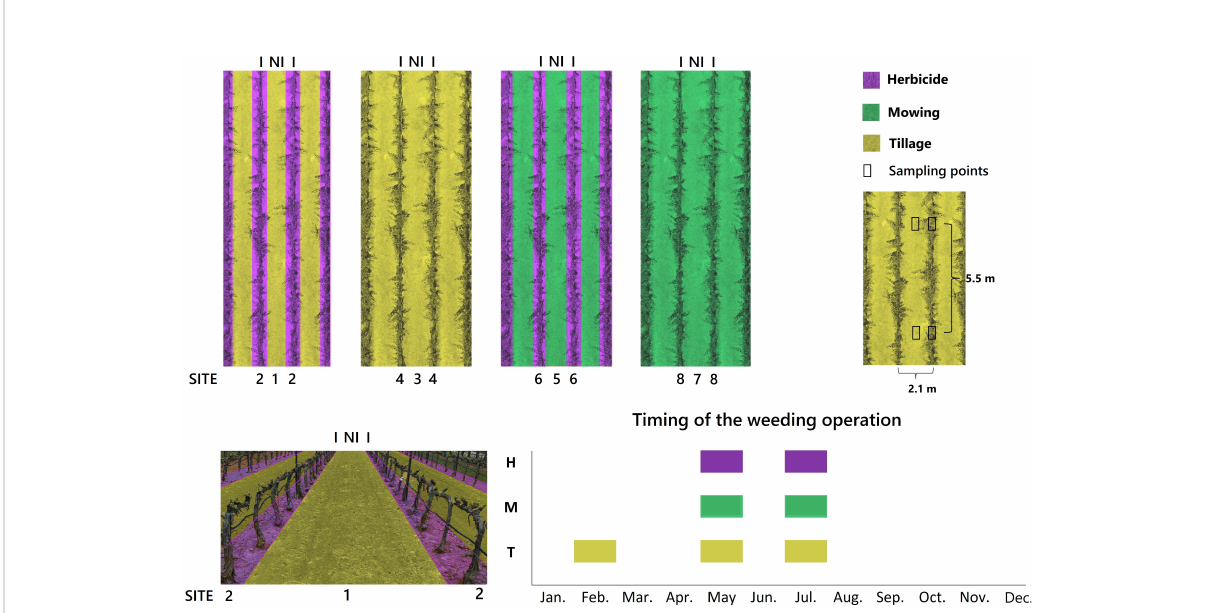
FIGURE 1 Diagram of the experimental design and location of the sampling points (upper part), 3D image depicting sites 2-1-2 (lower left) and schematic chronogram of the weeding operations carried out in the study fi eld (lower right). Irrigation treatment: I: irrigated row; NI, non-irrigated inter- row. Site: 1, tilled inter-rows adjacent to herbicide-treated plots; 2, herbicide-treated rows adjacent to tilled plots; 3, tilled inter-rows adjacent to tilled plots; 4, tilled rows; 5, mown inter-rows adjacent to herbicide-treated plots; 6, herbicide-treated rows adjacent to mown plots; 7, mown inter-rows adjacent to mown plots; 8, mown rows.